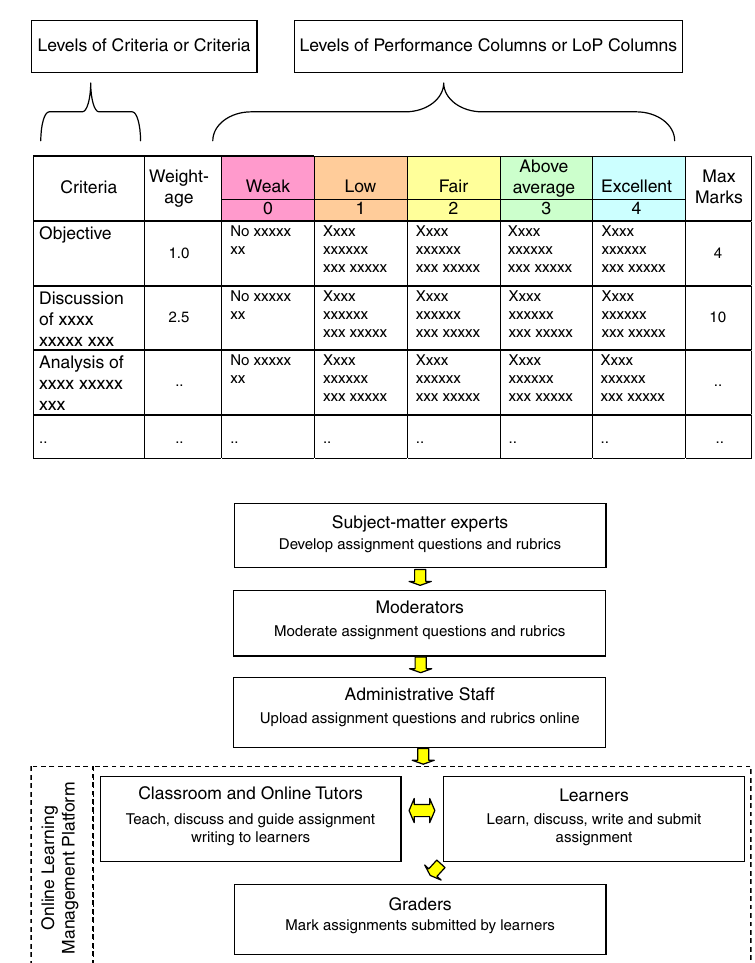
Figure 2. Stakeholders